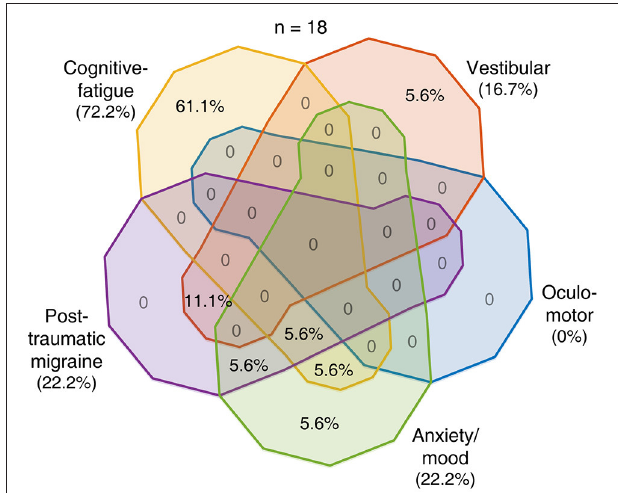
FIGURE 2 | Overlaps in post-concussion profile characteristics identified with severe symptoms . Eighteen of 89 concussed subjects reported having a severe post-concussion symptom. The distribution of these 18 subjects among the various combinations of presences and absences of endorsement of the five symptom classes is shown as percentages in the Venn diagram with areas of overlap among the five pear-shaped regions.